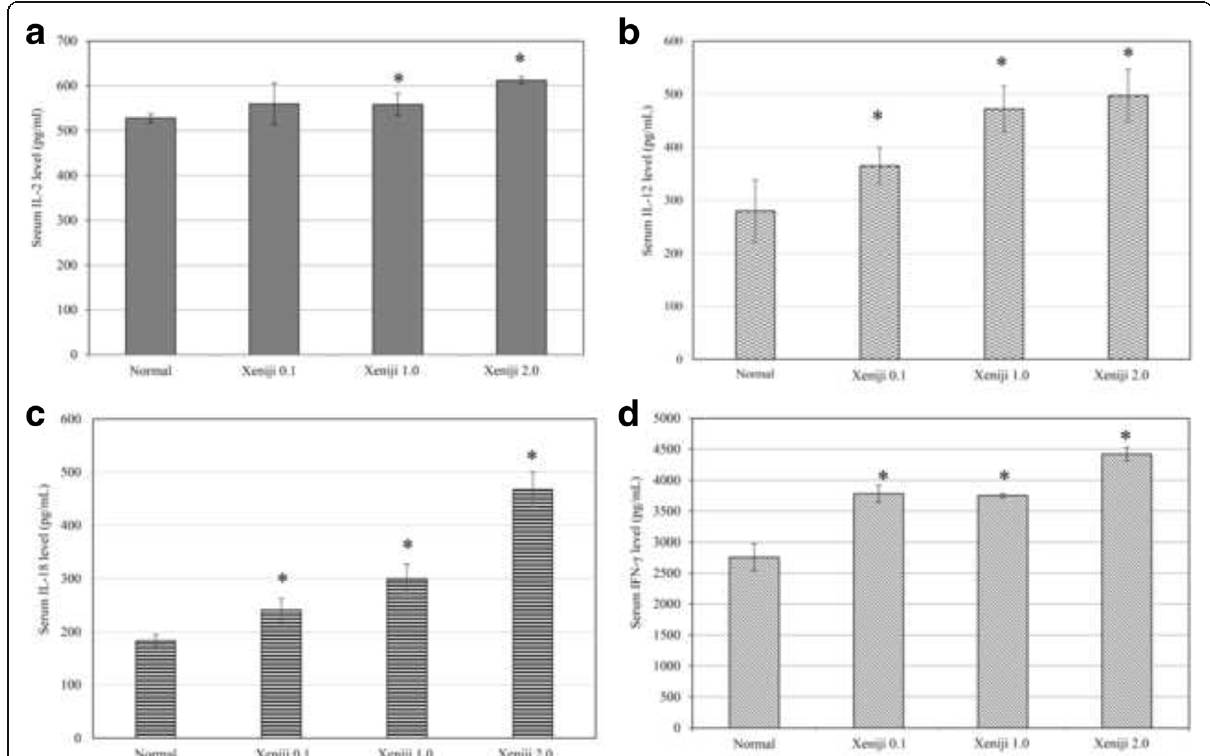
Fig. 4 Serum ( a ) IL-2; ( b ) IL-12; ( c ) IL-18 and ( d ) IFN- γ level in liver of normal and Xeniji (0.1, 1 and 2 g/kg body weight) treated mice. *indicates a significant difference compared with the normal control group, p <